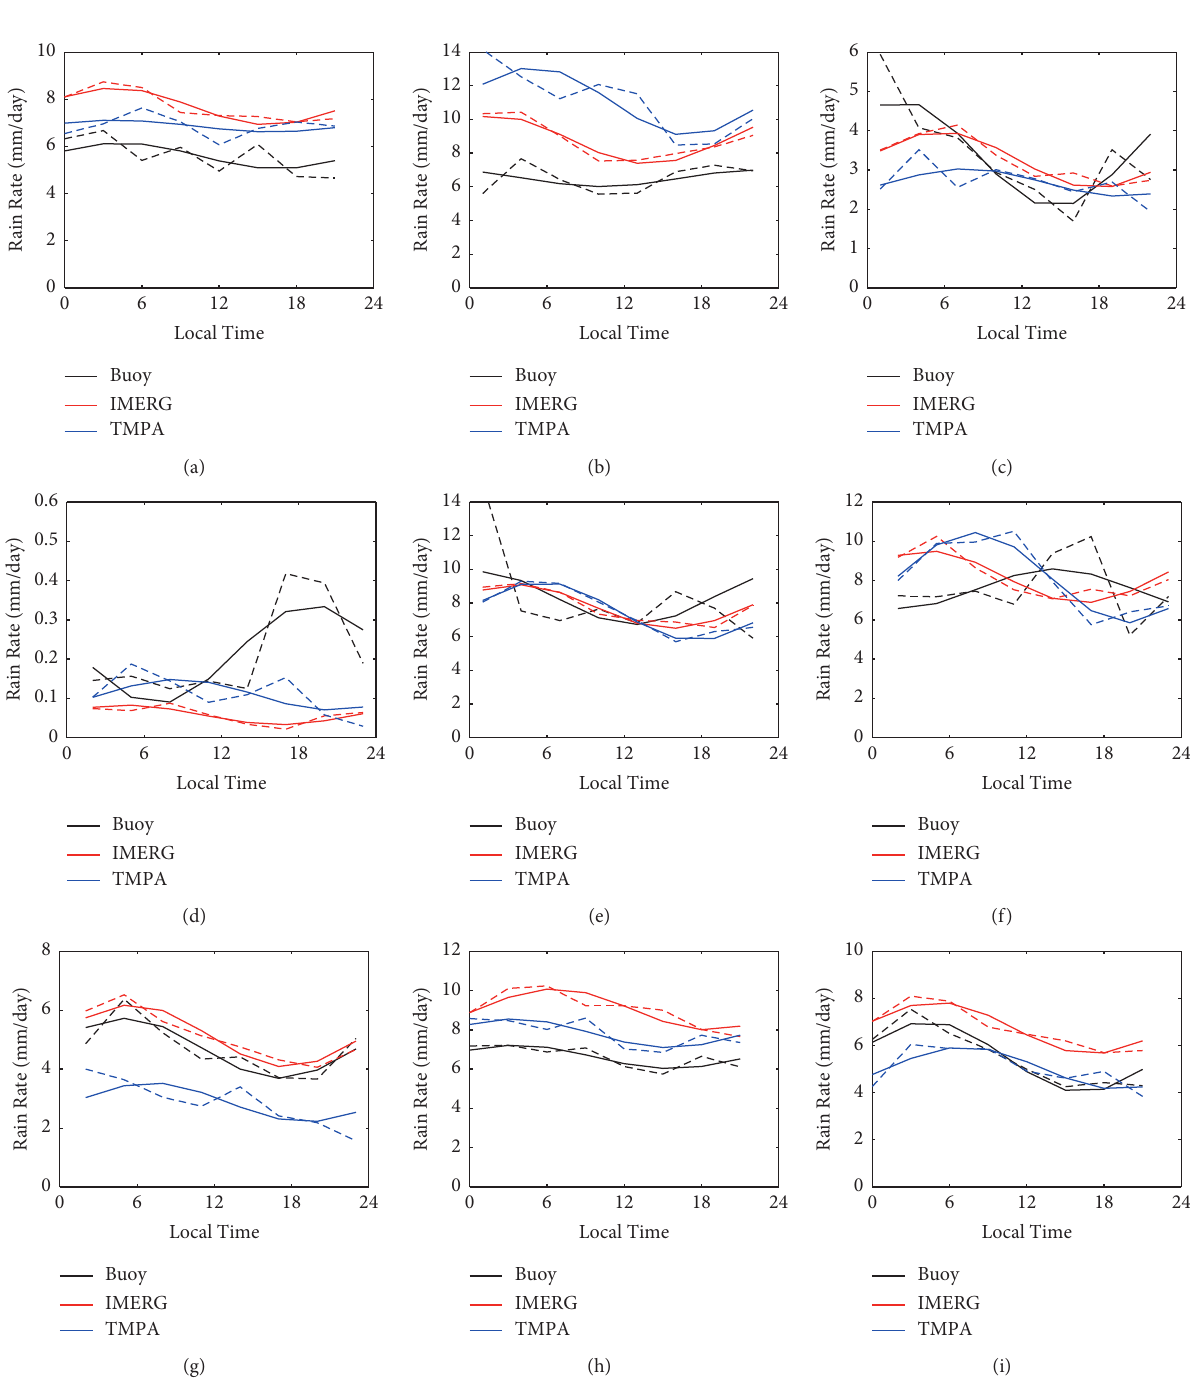
Figure 12: Climatological mean diurnal cycles (dashed lines) and fittings (solid lines) for nine buoys (black lines) and IMERG (red lines) and TMPA (blue lines) at each buoy location. Both IMERG and TMPA data were averaged to 5 ° × 5 ° centred on the buoys’